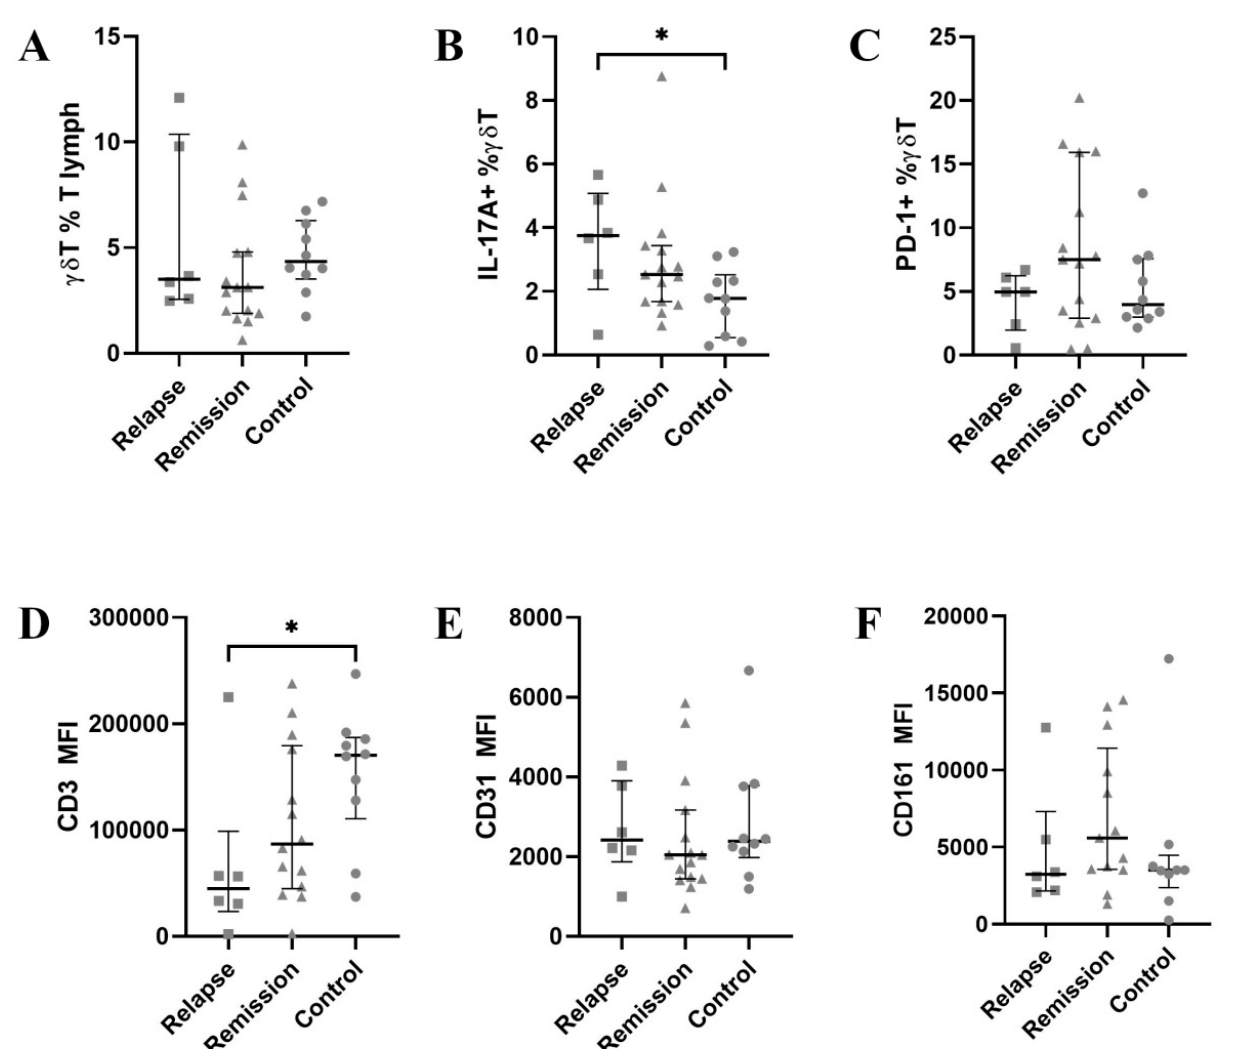
Figure 2. The results for the whole γδ T population. A horizontal line with whiskers represents a median with an inter-quartile range (IQR). ( A )—percentage of γδ T among total T cells, ( B )—percentage of IL-17+ γδ T cells, ( C )—percentage of PD-1+ γδ T cells, ( D – F )—MFI values for CD3, CD31 and CD161 respectively. MFI—mean fluorescence intensity. * denotes p < 0.05.